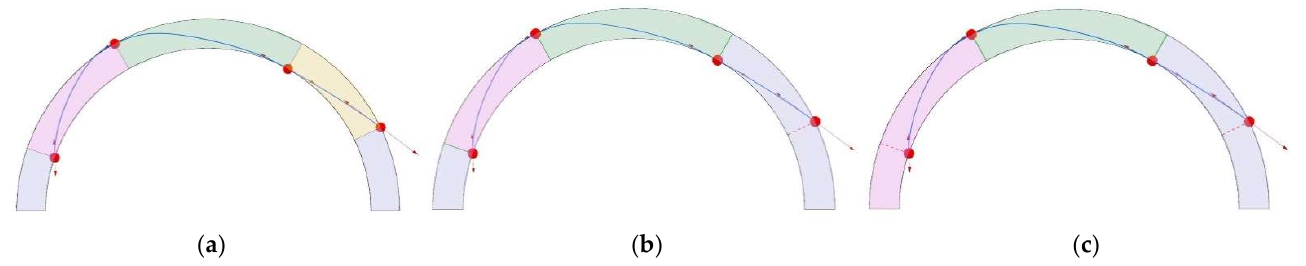
Figure 14. Optimal solutions found by Equation (9) for the three friction angles of: ( a ) 35°; ( b ) 27.28°, and ( c ) 17.6°.